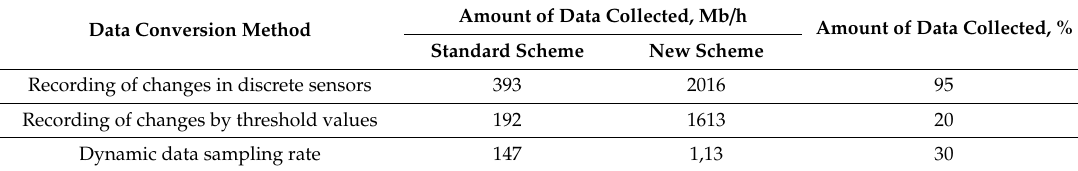
Table 5. Evaluation of the e ff ectiveness of the conversion data on fog nodes.